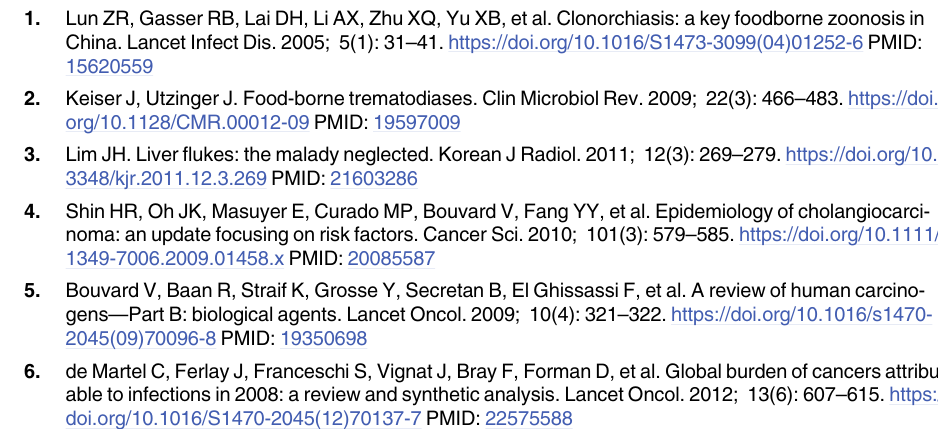
S4 Table. Survival time of C . sinensis adults with or without MB05032 treatment. Survival time was evaluated by the log-rank test. P < 0.01 and P < 0.0001 were represented as statistical